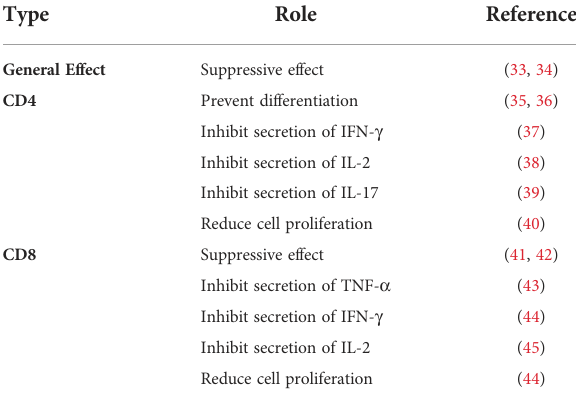
TABLE 2 Effects of n-3 PUFAs supplementation on T